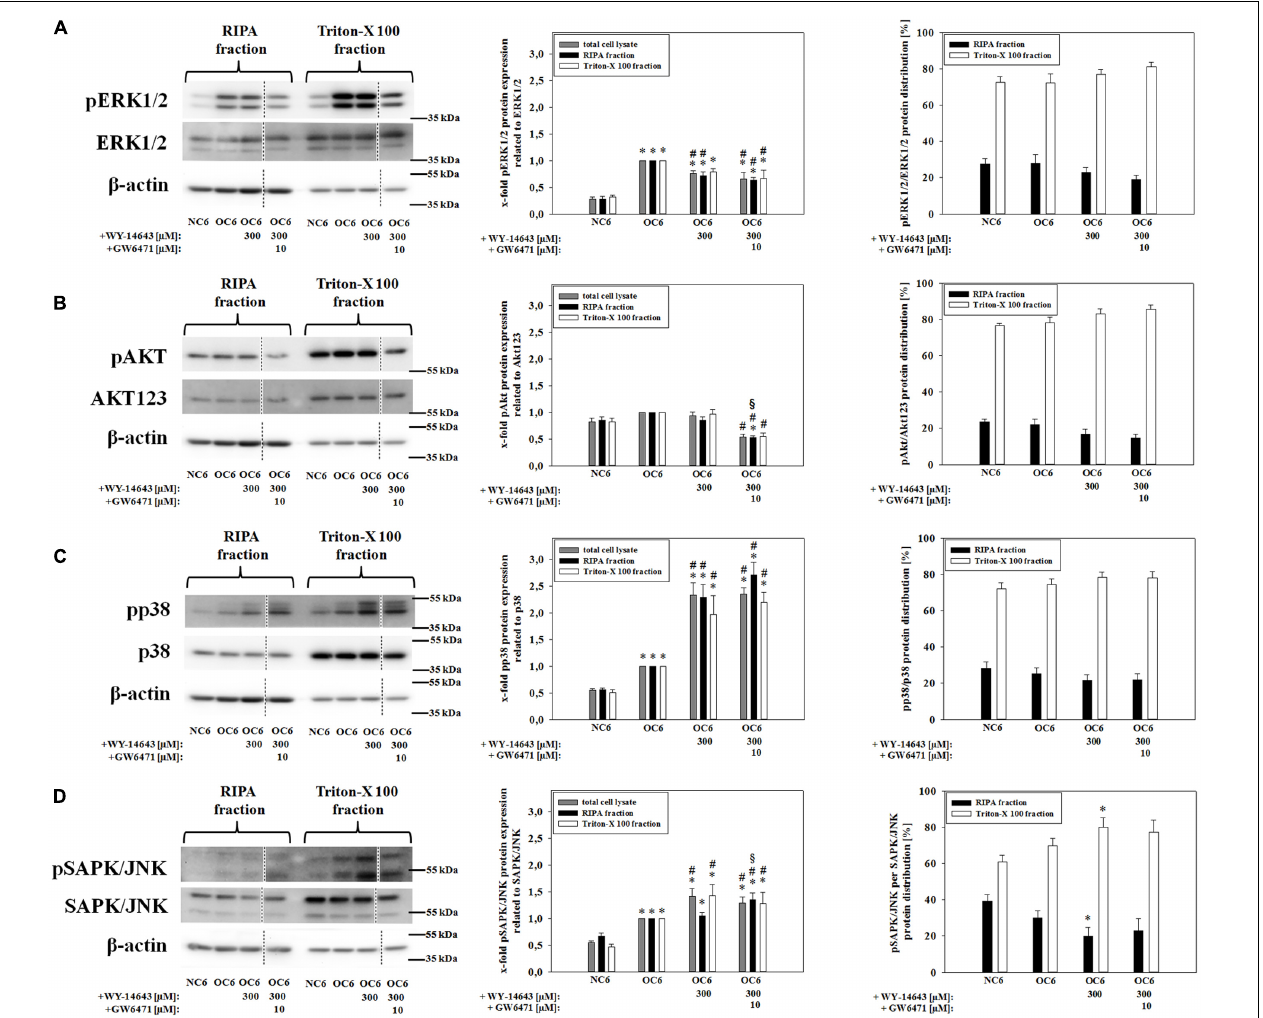
FIGURE 3 | Influence of WY-14643 and PPAR α antagonist GW6471 on effects of OC6 treatment on phosphorylation ratios of MAP kinases ERK1/2, Akt, p38, and SAPK/JNK of cerebEND cells. OC6 treatment of cerebENDs accords to 4 h OGD treatment with medium supernatants derived from 4 h OGD-treated C6 cells, whereas NC6 treatment means cerebEND cells incubated for 4 h under normoxic conditions with medium supernatants of 4 h normoxic treated C6 cells. Results for ERK1/2 (A) , Akt (B) , p38 (C) , and SAPK/JNK (D) were displayed. Densitometric analyzed protein expression of total cell lysates were compared to RIPA and triton-X 100 fractions. Moreover, protein distributions [%] between cytoskeleton (RIPA) and membrane enriched fractions (triton-X 100) were presented. Values were related to β -actin and according representative western blot images are depicted. Dotted lines indicated cuts of images of the same blot due to presentation reasons of selected bands. Statistical significance was labeled with ∗ vs. NC6, # vs. OC6 and § vs. OC6 + WY ( p < 0.05). Data are presented as means ± SEM ( n =